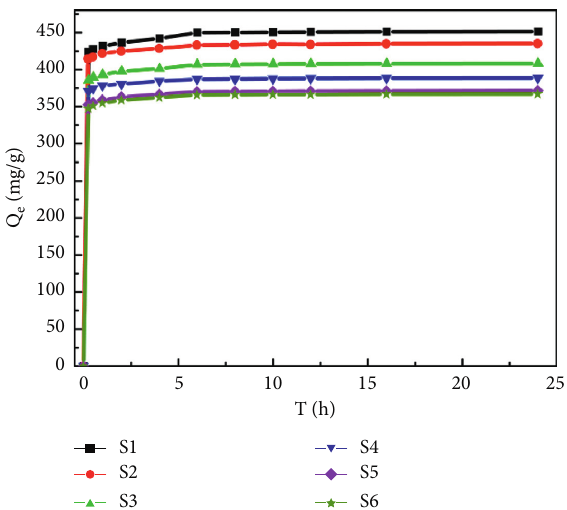
Figure 9: Effects of contact times on adsorption capacity of Cr(VI) on various Fe